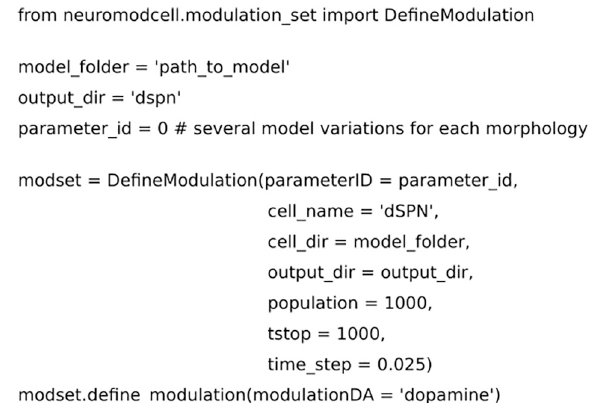
FIGURE 2 | Code for setting up the parameters for neuromodulation using Neuromodcell . The parameter, “path_to_model,” defines the path to the model and which specific parameterID, parameter_id . mod_set.define_neuromodulation , the naming defines the neuromodulation key, DA for dopamine. The example has a simulation time of 1000 ms and population of 1000 different models.